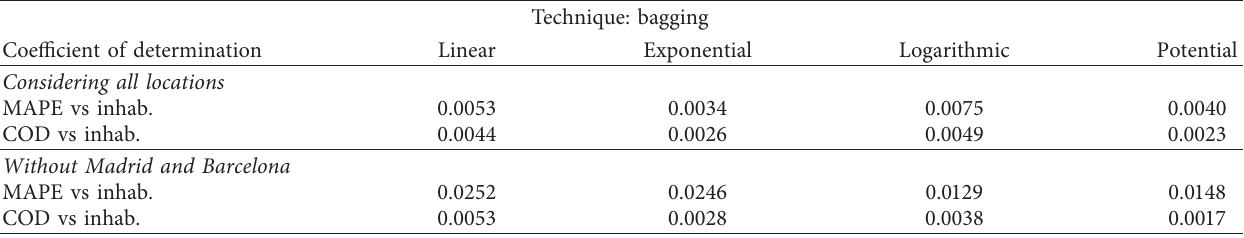
Figure 2: Bagging’s MAPE and COD versus municipality population considering all the locations and without Madrid and Barcelona. (a) MAPE vs inhabitants, bagging. (b) MAPE vs inhabitants, bagging without Madrid and Barcelona. (c) COD vs inhabitants, bagging. (d) COD vs inhabitants, bagging without Madrid and Barcelona. Note. Own elaboration. Table 2: Coefficients of determination of the regression between Bagging’s MAPE and COD and municipality population considering all the locations and without Madrid and Barcelona.